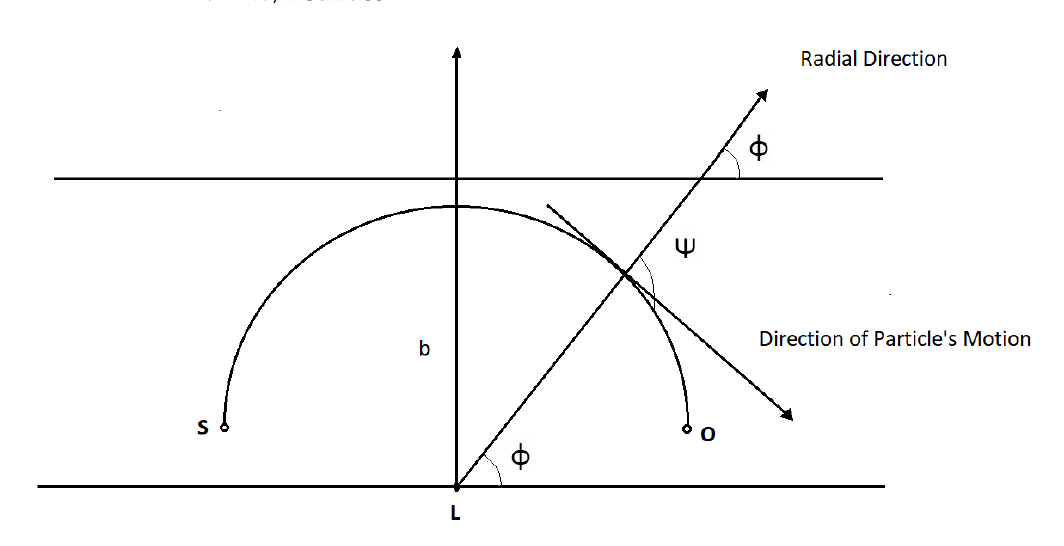
Figure 1. Schematic diagram of the orbital motion of the massive particle (here in the weak field limit, i.e., closest approach ≈ impact parameter,